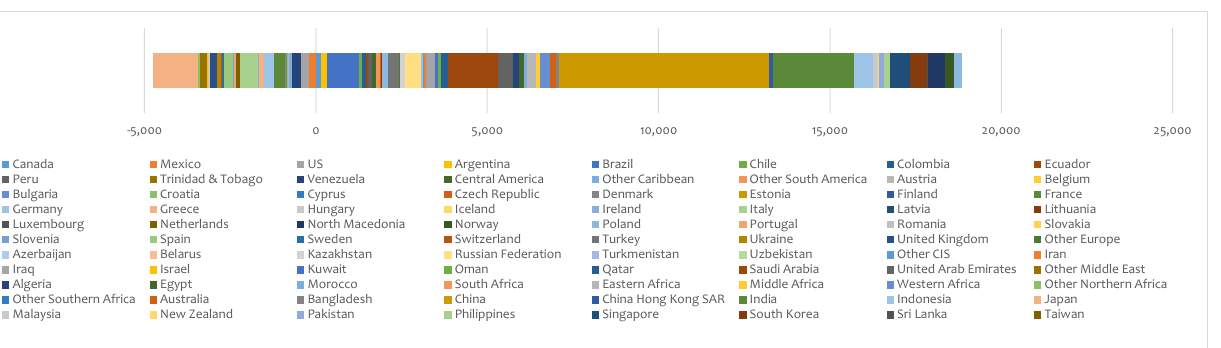
Figure 8. Changes in global oil production by country in 2006–2018 (data were collected from [22]).